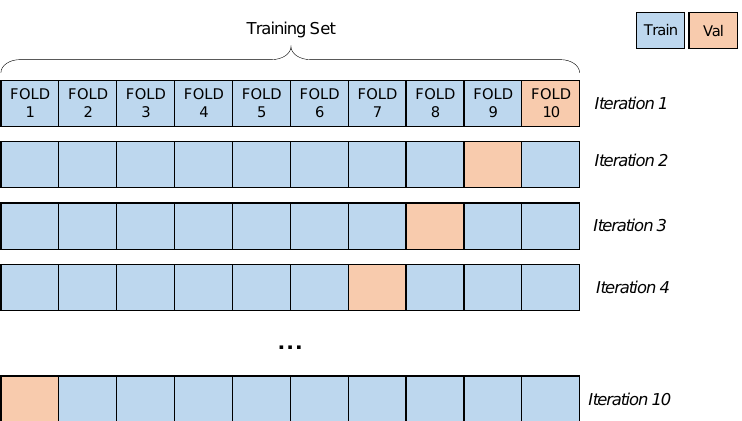
Figure 12. Iterations of the 10-fold cross-validation procedure. Blue folds are used for training, whereas orange folds are used for validating the